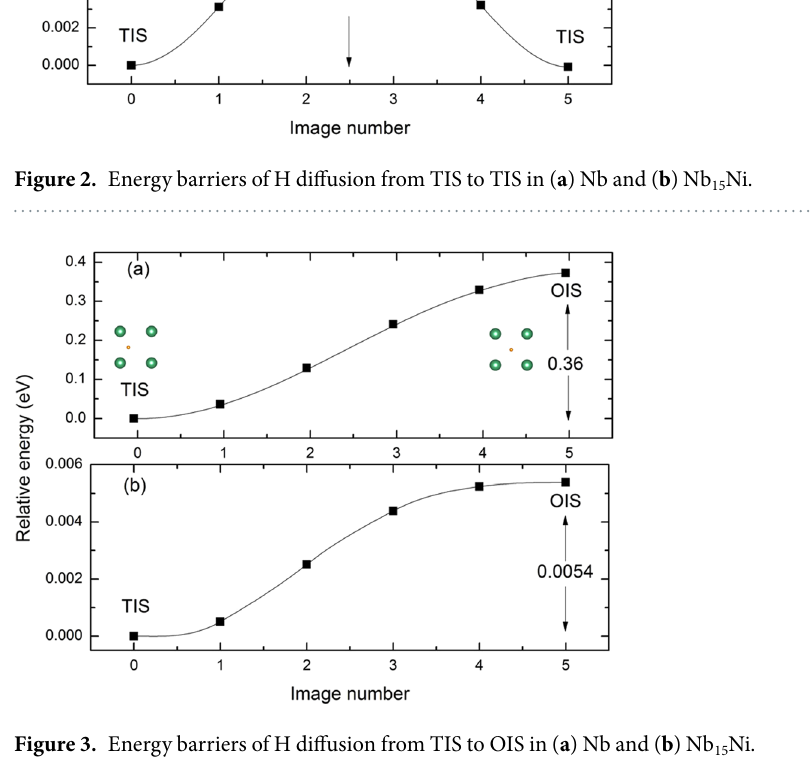
Figure 3. Energy barriers of H diffusion from TIS to OIS in ( a ) Nb and ( b ) Nb 15